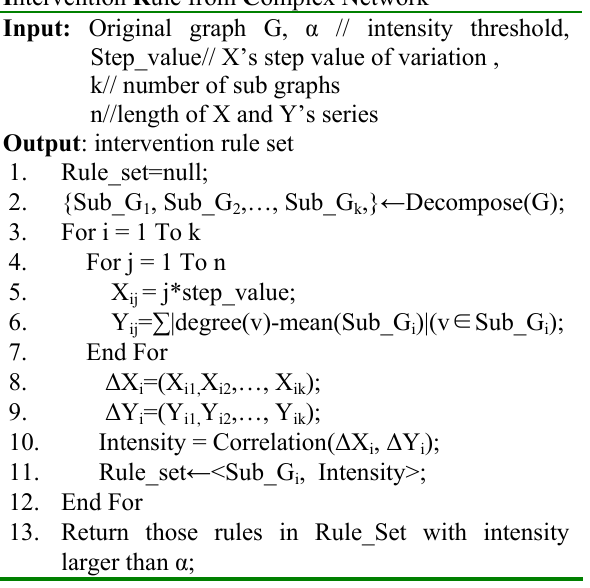
algorithm 1. Line 3~ 12 is to generate intervention rules